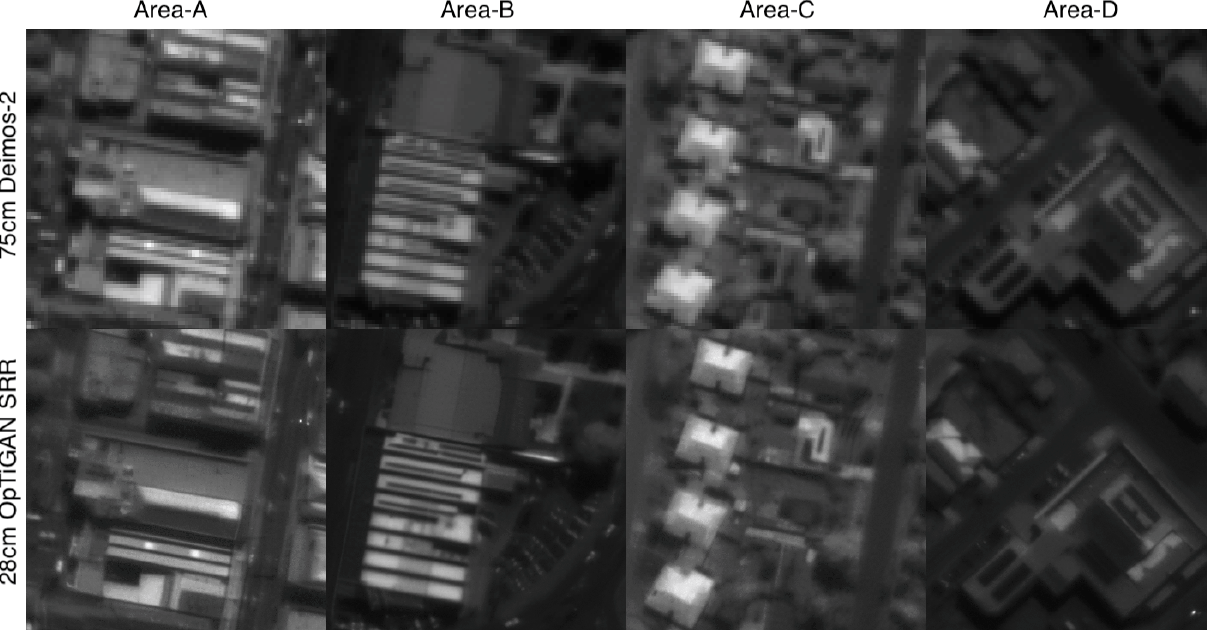
Figure 14. Examples of the 75 cm/pixel Deimos-2 image (DE2_PAN_L1B_000000_20180506T021306_20180506T021310) crops and the corresponding OpTiGAN SRR results showing residential building blocks over the Adelaide site. All sub-figures have a size of 87.5 m by 87.5 m. Deimos-2 image courtesy of Deimos Imaging, S.L. 2021.